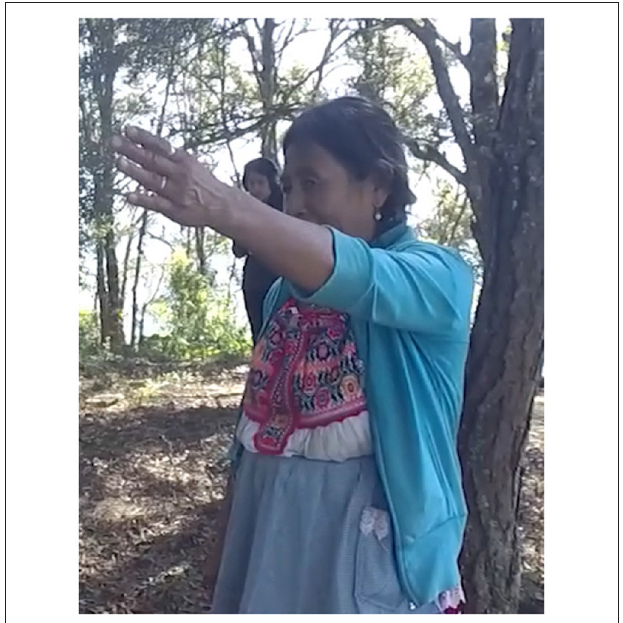
FIGURE 8 | Dem. + manual point [target: